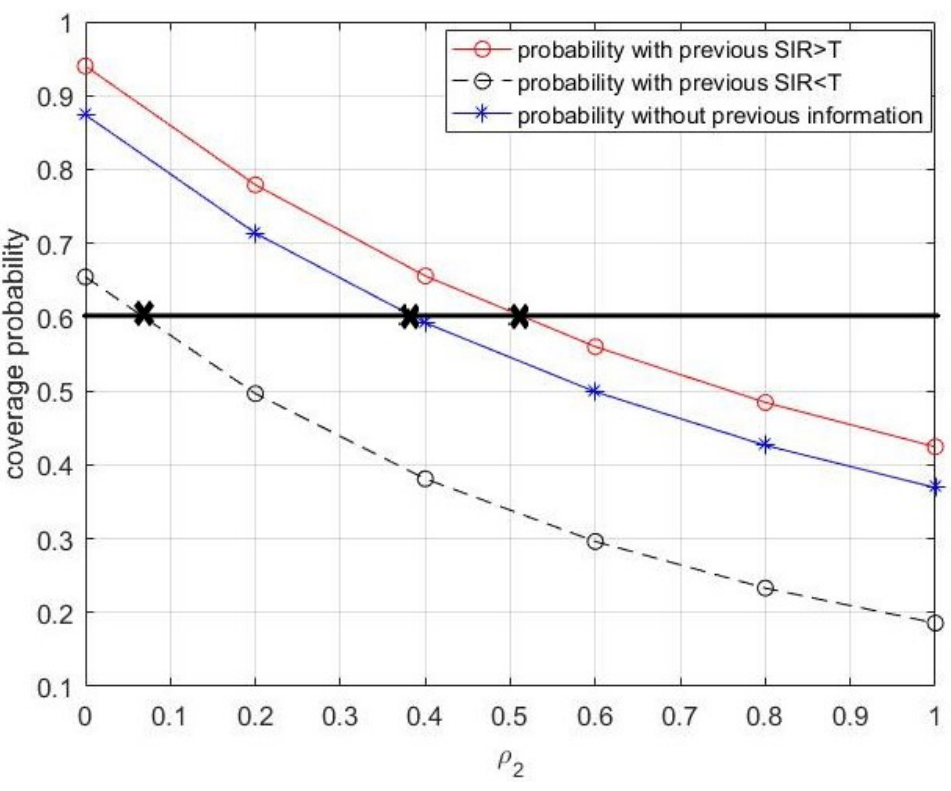
Figure 3. The coverage probability comparison of CUE v.s. ρ 2 with ρ 1 = 0.5 and λ 1 = 10/km 2